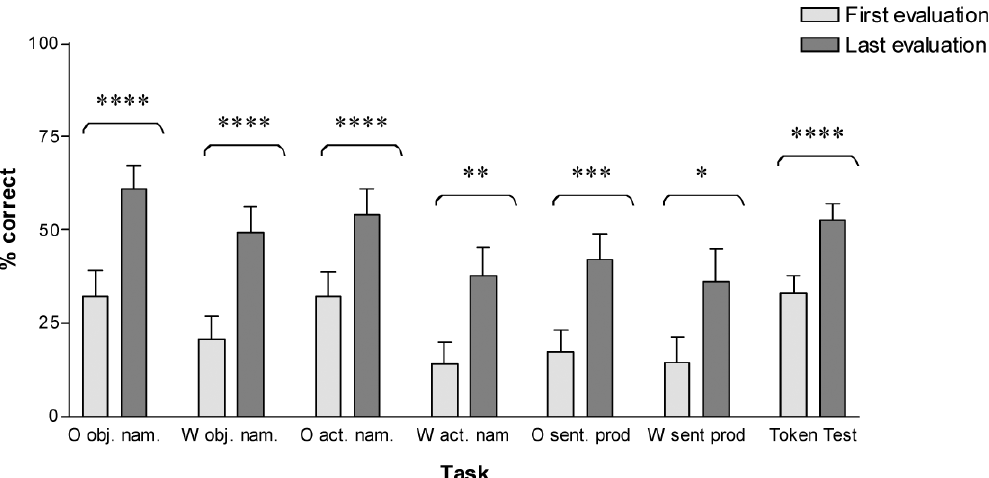
Fig. 1. Comparison of mean scores (%) in oral noun naming, written noun naming, oral action naming, written action naming, oral sentence production, written sentence production and Token Test scores at fi rst and last evaluation of the 23 treated subjects. Error bars are SEM (standard error of the mean). Legend: O = Oral, W = Written, obj. nam = Noun naming, act. nam. = Action naming, sent. prod. = Sentence production, ∗ p = 0.002, ∗∗ p = 0.001, ∗∗∗ p = 0.0002, ∗∗∗∗ p < 0.0001.